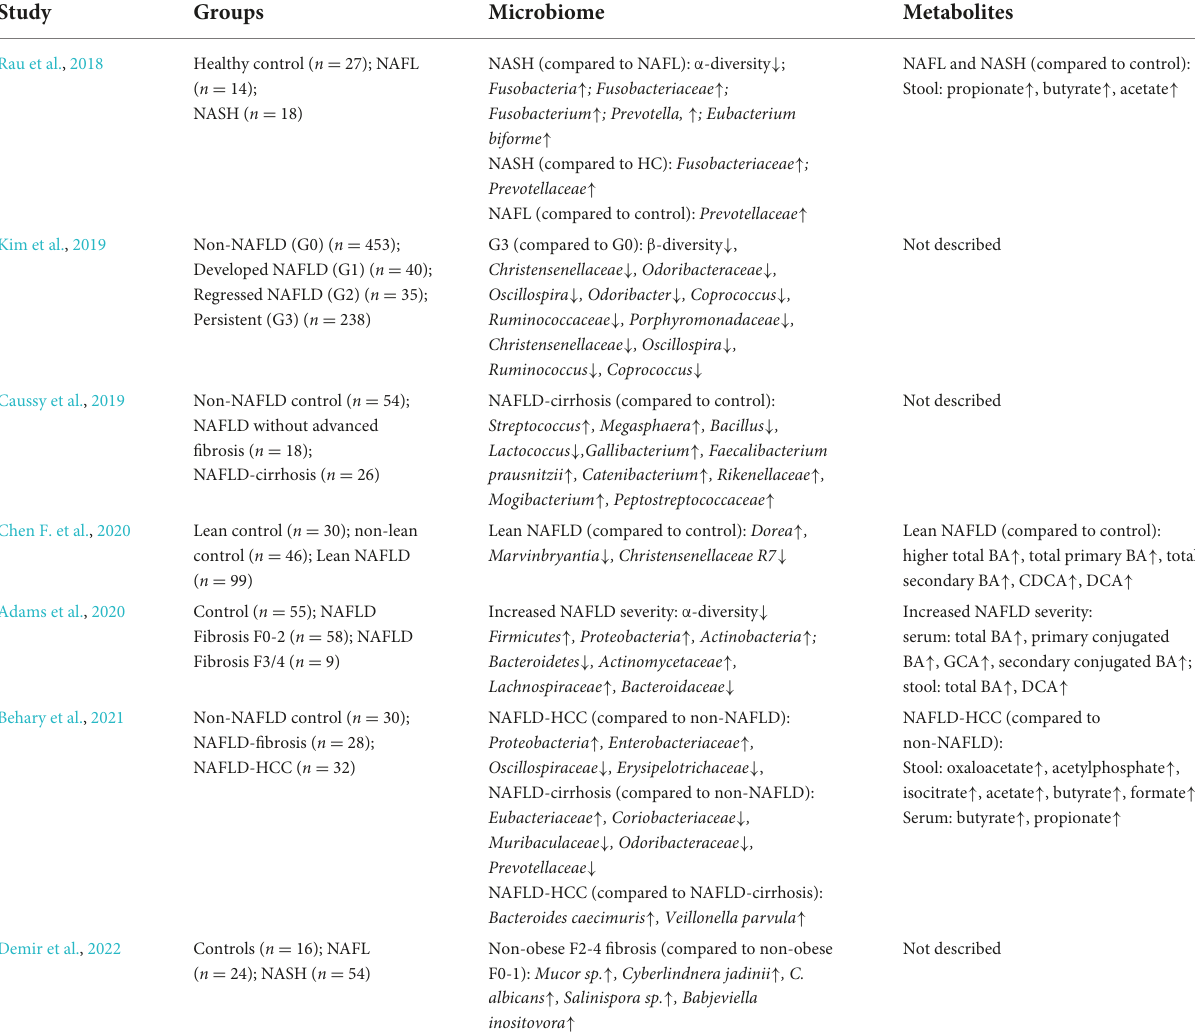
TABLE 1 Clinical studies of the gut microbial changes in NAFLD